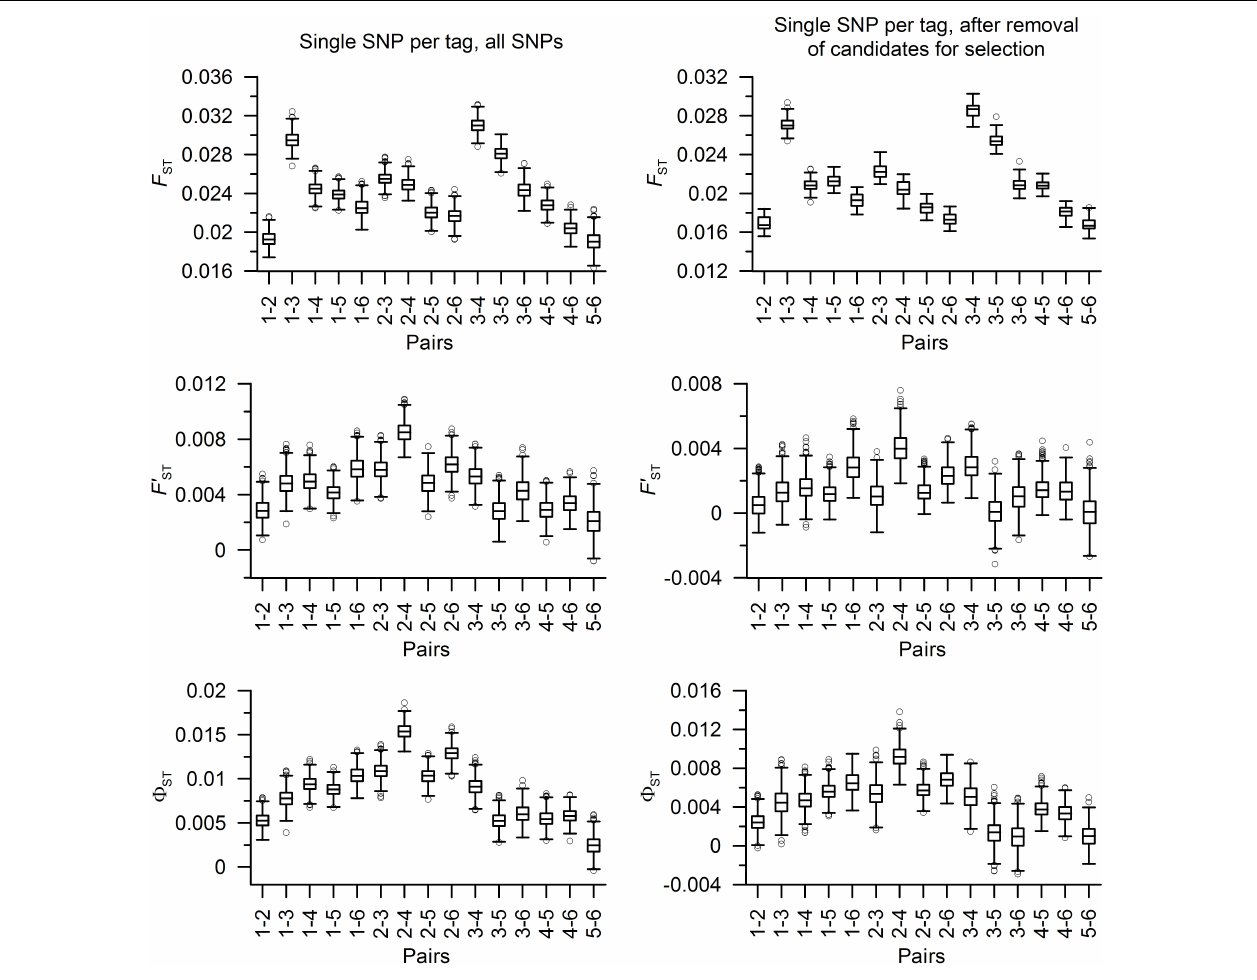
FIGURE 4 | Box and whiskers plot showing quartiles (box), 95% confidence interval (whiskers) and outliers (circles) of F -statistics between regions, derived from 1,000 iterations using randomly chosen sets of SNPs. The three F -statistics indicate closer relationships between the Chukchi Borderland and Beaufort Sea samples (Pacific Arctic), and between the other four regional samples (Eurasian and Amerasian Basins, Fram Strait, and Labrador Sea). After removal of markers deemed to be candidates for selection, the pattern was less clear, although there remained clear differences. NB: Y -axis units differ between statistics. Key: 1: Beaufort Sea; 2: Chukchi Borderland; 3: Amerasian Basin; 4: Eurasian Basin; 5: Fram Strait; 6: Labrador